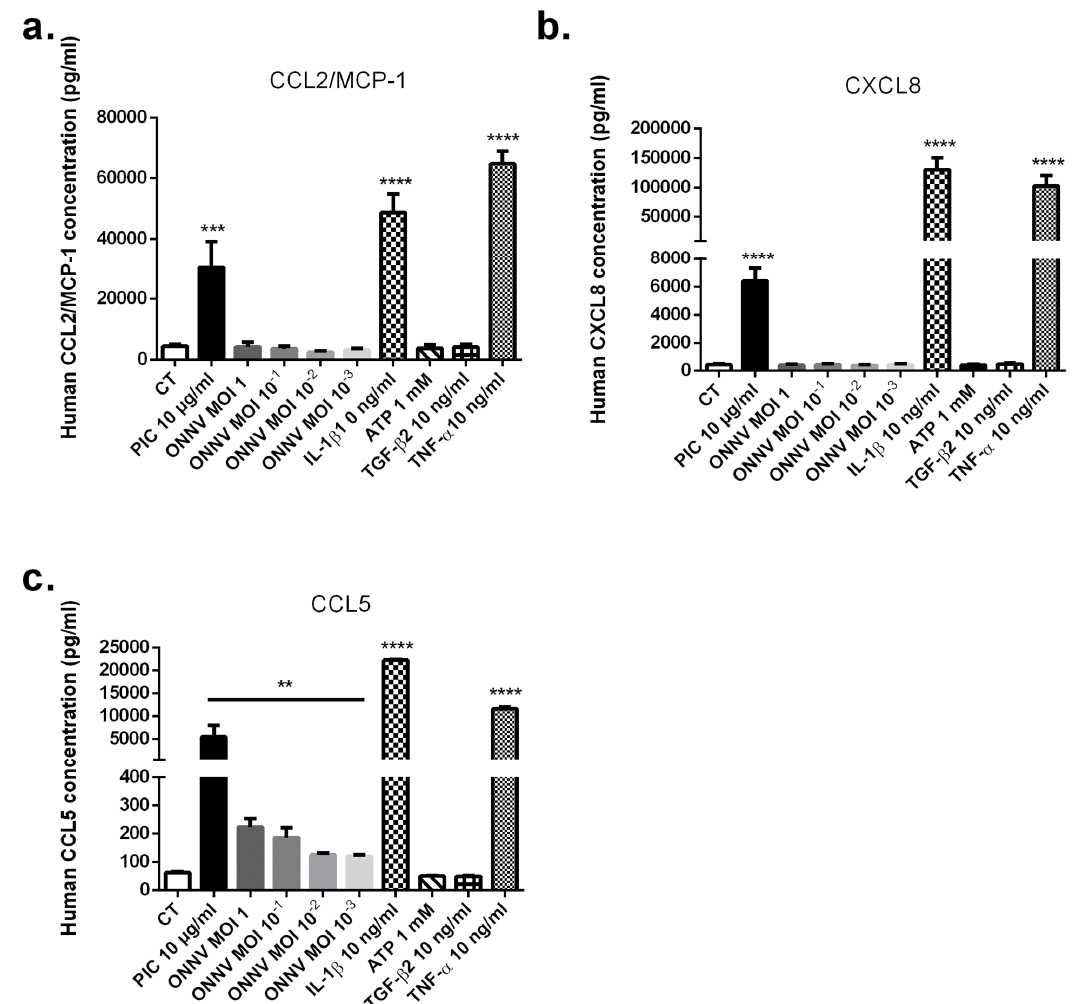
Figure 7. SC can modulate proinflammatory chemokine production in response to PIC and proin- flammatory cytokines (IL-1 β and TNF- α ) stimulation and ONNV infection. SC were infected with ONNV (from MOI 10 − 3 to 1) or exposed to stimulatory treatments (PIC 10 µ g/mL, IL-1 β 10 ng/mL, TNF- α 10 ng/mL, TGF- β 2 10 ng/mL, and ATP 1 mM). Supernatants were harvested after 24 h and levels of CCL2 ( a ), CXCL8 ( b ), and CCL5 ( c ) were quantitated by ELISA assay. All experiments were done in quadruplicates and results are expressed as mean ± standard error. ** p -values ≤ 0.01, *** p -values ≤ 0.001, and **** p -values ≤ 0.0001represent significant differences from controls by one-way ANOVA followed by the Bonferroni’s test